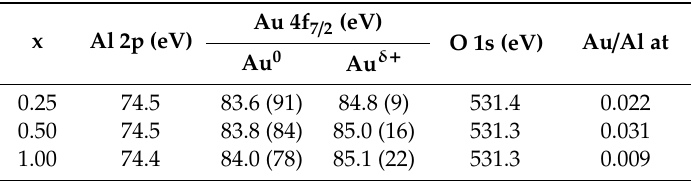
Table 2. Binding energies (BE) of internal levels and atomic ratio of (x)Au/ANW catalysts. (Percentage in brackets).